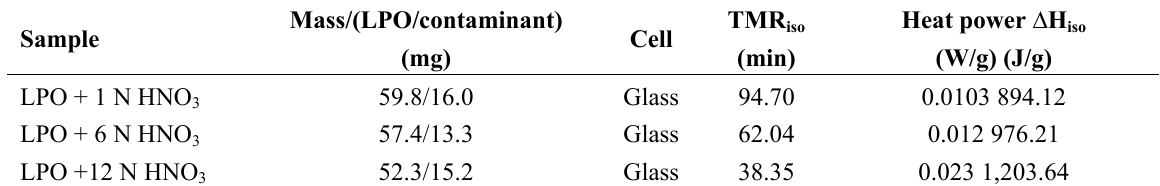
Table 3. Experimental data by TAM III tests for 95 mass% LPO with various concentrations of HNO at 60 °C. 3